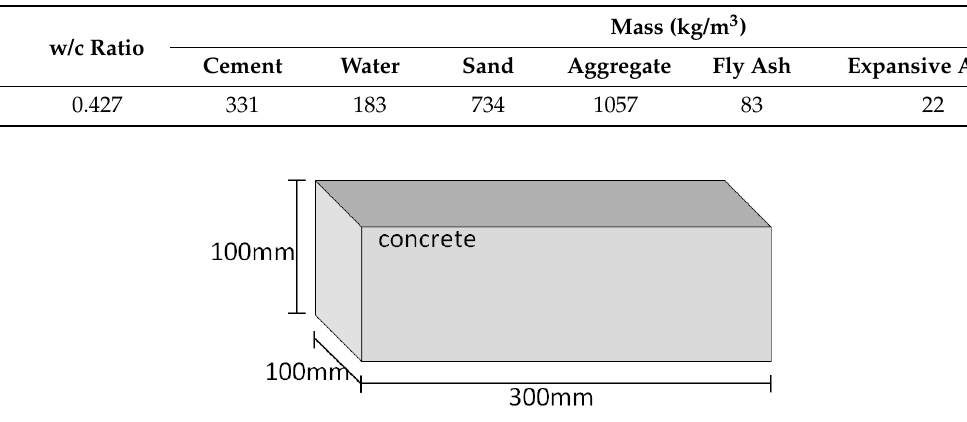
Figure 1. Concrete Figure 1. Concrete specimens.